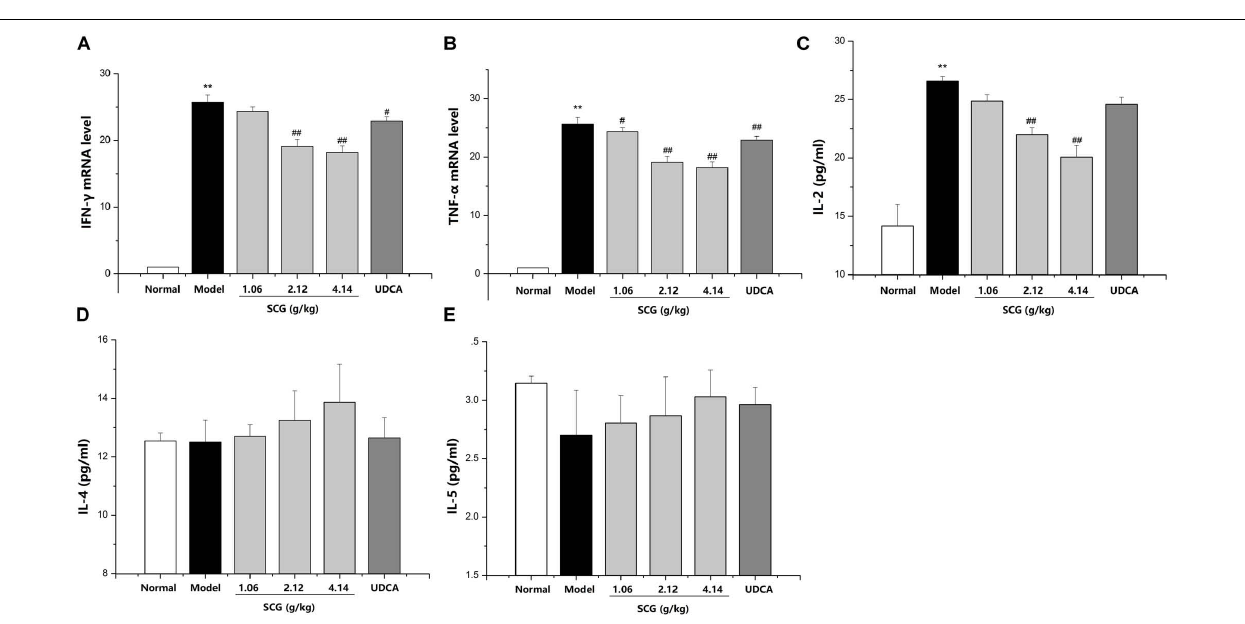
FIGURE 5 | Effect of SCG on the levels of inflammatory cytokines in Con A-induced liver injury. (A) The expression level of IFN- γ . (B) The expression level of TNF- α . (C) The expression level of IL-2. (D) The expression of IL-4. (E) The expression level of IL-5. Data were expressed as mean ± SD ( n = 6). ∗∗ P < 0.01 compared with normal group; # P < 0.05, ## P < 0.01 compared with model